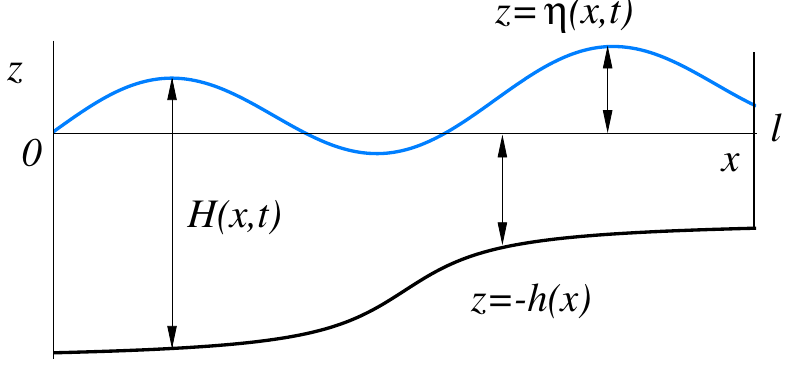
Figure 5. A sketch of the fluid domain in shallow water